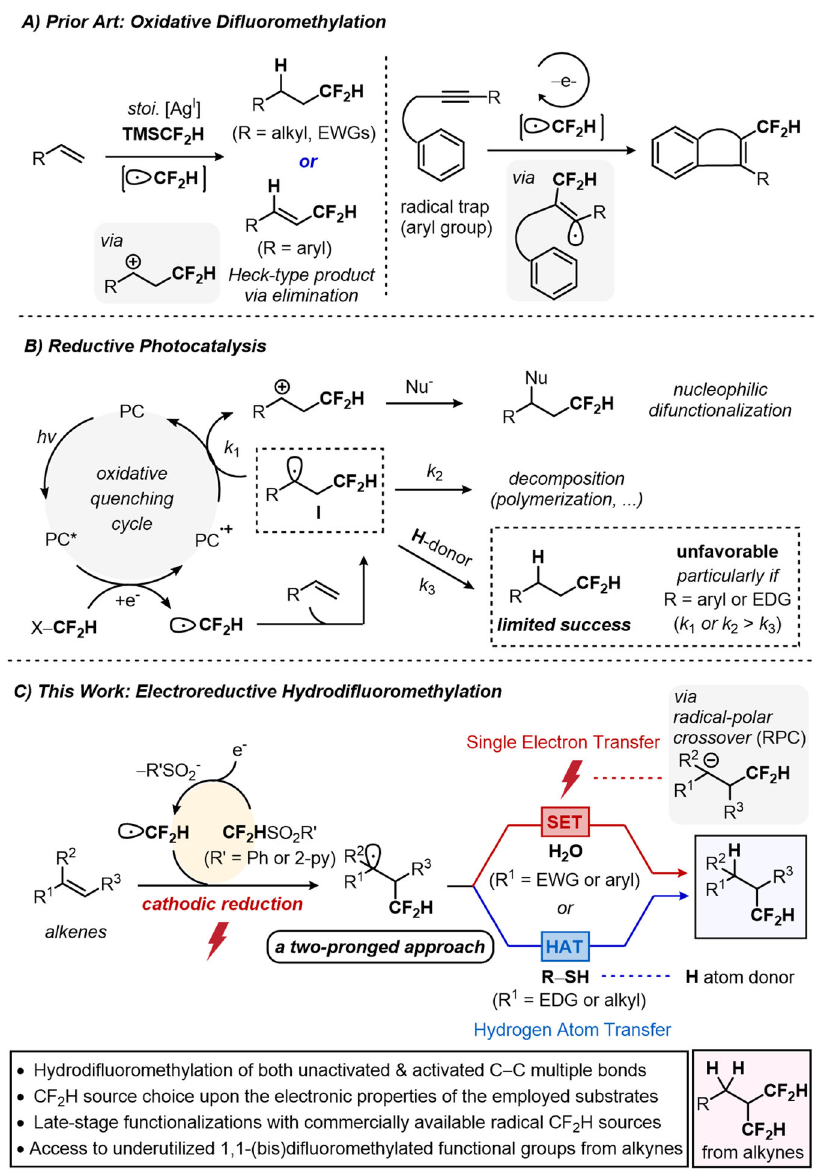
Fig. 1 Radical hydrodi fl uoromethylation of unsaturated C – C bonds. A Precedent examples of di fl uoromethylation under oxidizing conditions. B Reductive photocatalysis for radical di fl uoromethylation. C A two-pronged electroreductive hydrodi fl